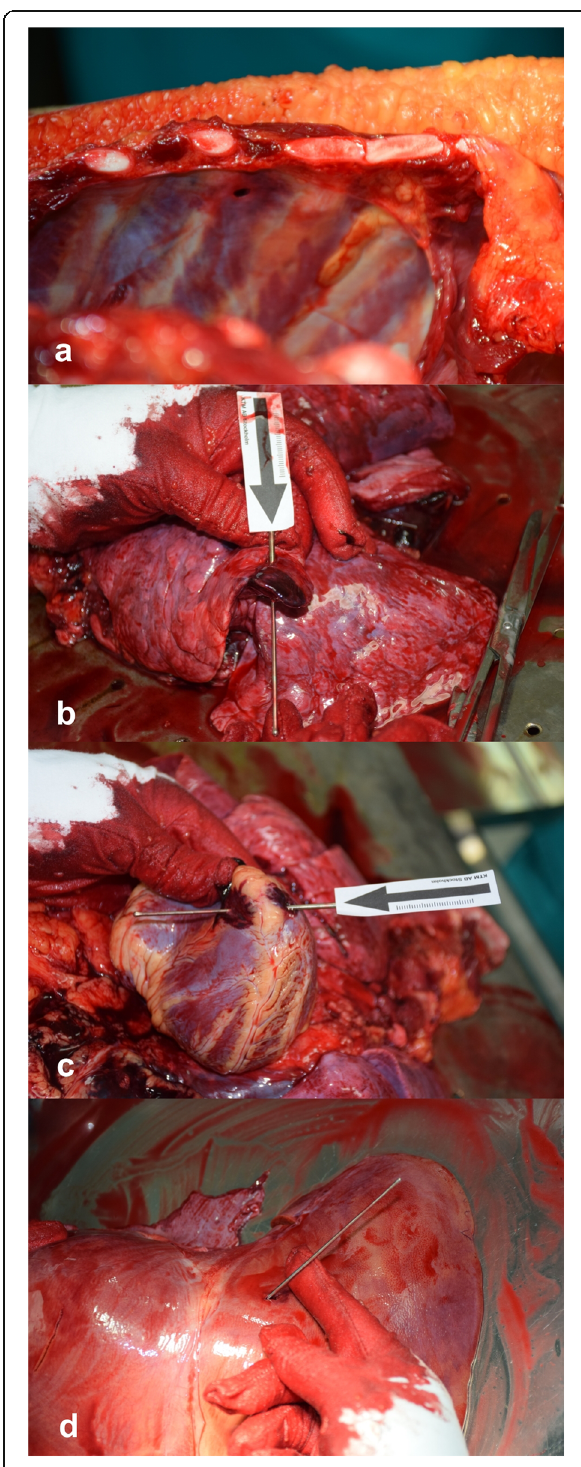
Fig. 4 The wound path running below the 5th rib ( a ), through the lower left lung ( b ), through the apex of the heart ( c ), and entering the left lobe of the liver ( d